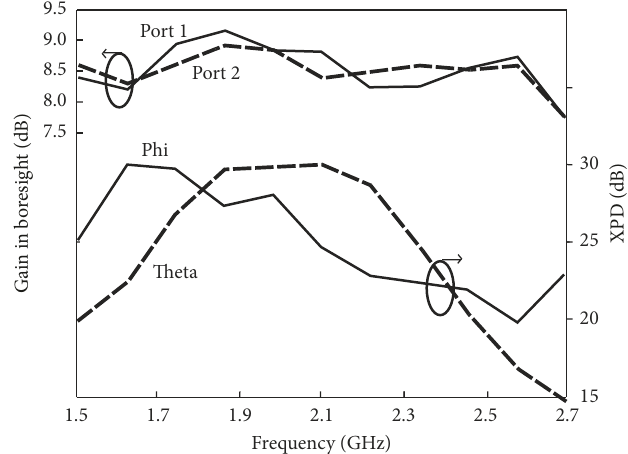
Figure 5: Measured total gain and XPD in boresight as a function of frequency.